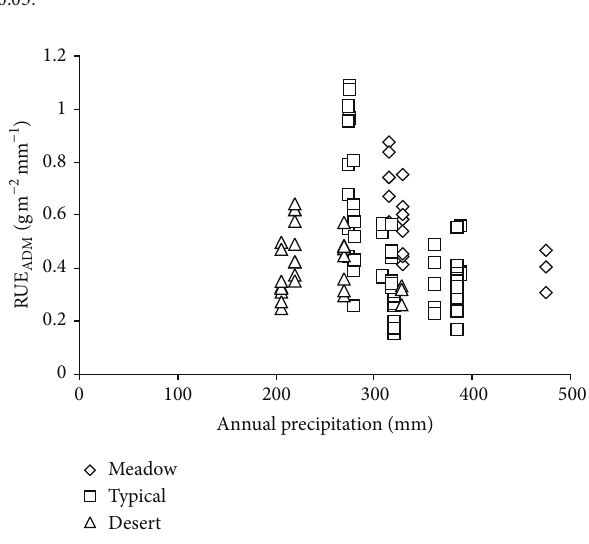
Figure 3: Relationship of RUE ADM (gm −2 mm −1 ) with annual precipitation (mm) in meadow steppe, typical steppe, and desert steppe across the grasslands of Inner Mongolia. RUE ADM = rain use efficiency based on above ground dry matter.